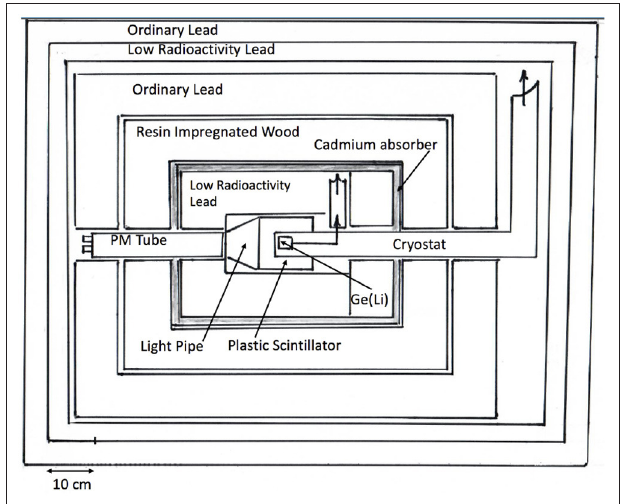
FIGURE 1 | A diagram of the Milan Mont-Blanc Tunnel Double-Beta Decay Experiment.